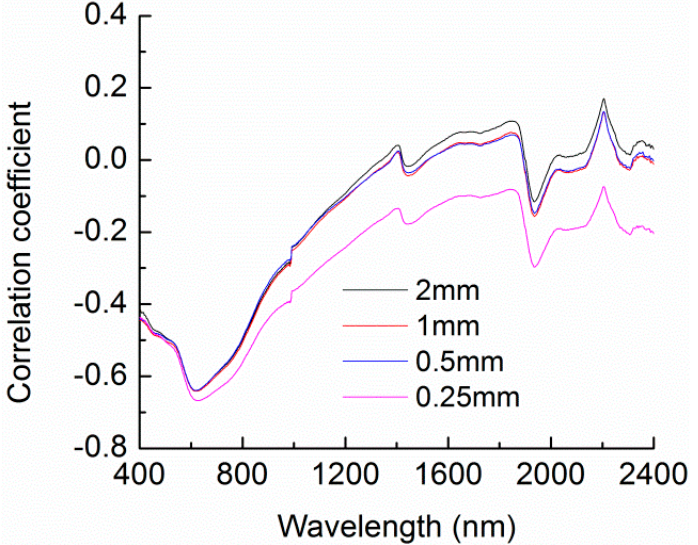
Figure 3. Correlation between original spectral reflectance (REF) and organic matter content of the four particle sizes.